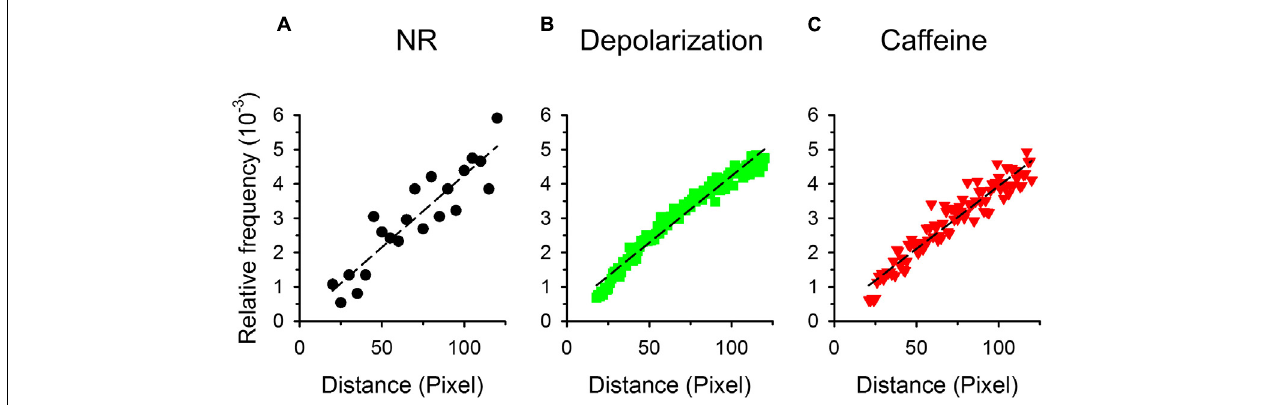
FIGURE 6 | Distribution of the distances between the centers of two sparks. For each spark concentric squares were constructed around the center of the selected spark. The number of sparks with centers falling onto the side of the given square were then counted. The relative frequency of these neighboring sparks are presented for control conditions (A) , for depolarized (B) , and caffeine-treated fibers (C) . Note that in this representation the number of pixels increases linearly with the length of the side of the square, thus if sparks appear randomly a linearly increasing distribution is expected. To avoid the problem of bringing pixels from outside of the fiber into the counting 1./only those sparks were selected that lay close to the center of the fiber and 2./the side of the square was restricted to being less the 120 pixels (appr. 25 µ m). Thus in the panels (A–C) the ordinate is in pixels. Dashed lines represent least-squares fits of a straight line to the data points in each graph with R 2 being 0.829, 0.964, and 0.918, for panels (A–C) ,